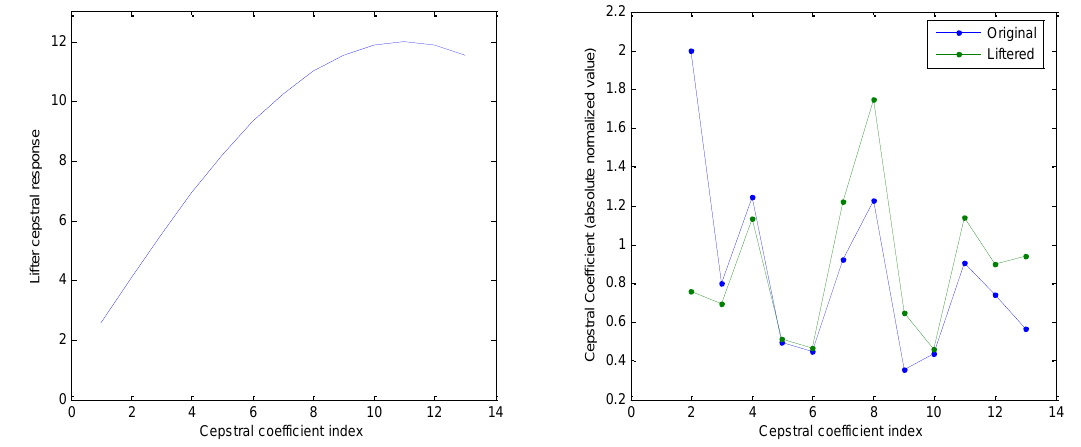
Figure 16. Cepstral sine lifter: ( left ) lifter cepstral response; ( right ) effect on cepstrum.